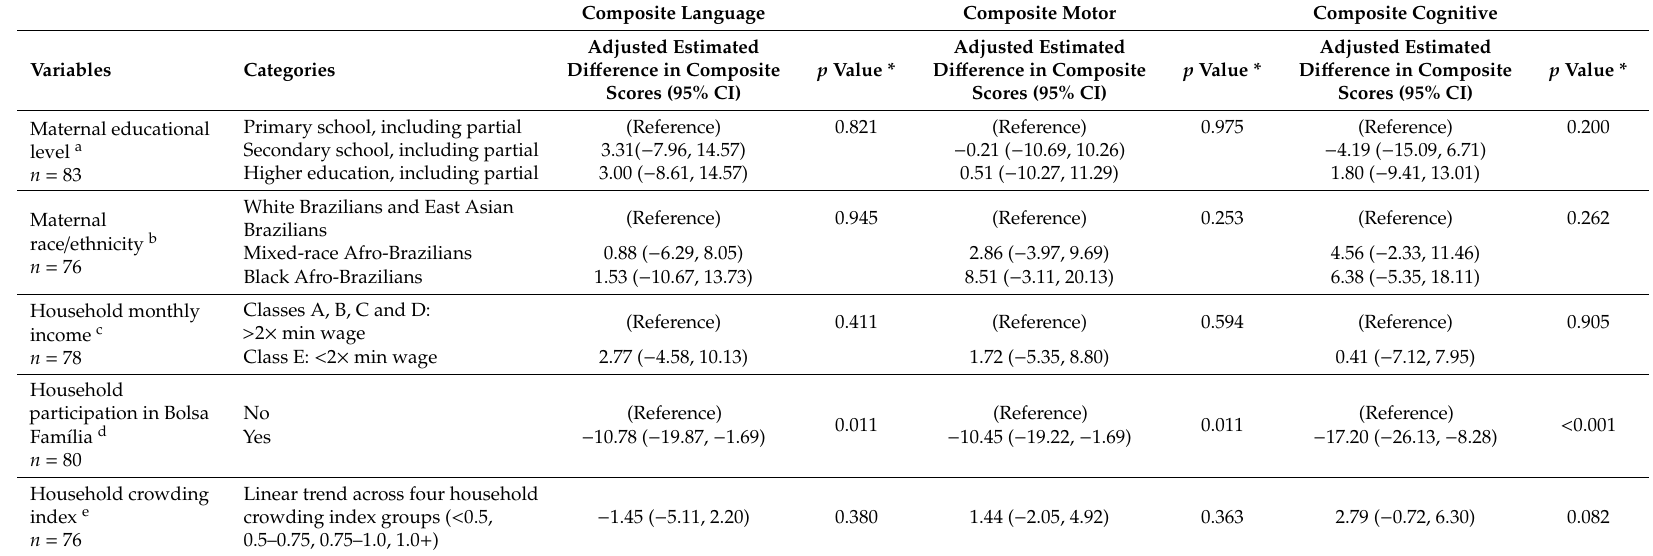
Table 4. Adjusted estimated di ff erences in Bayley-III assessment scores according to risk factors, in the normocephalic study sample (n =